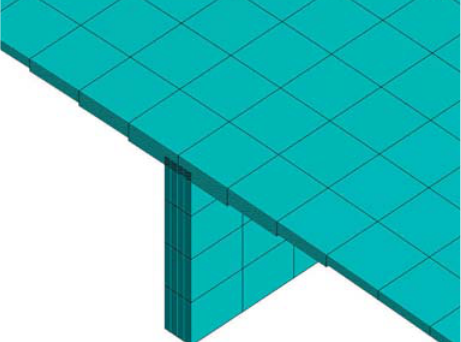
Fig 6. Finite element model with zoom for